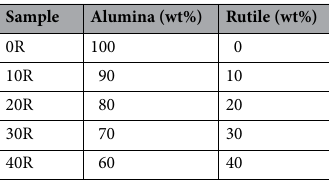
Table 2. Designation (wt%) of the different A/AT ceramic composites.